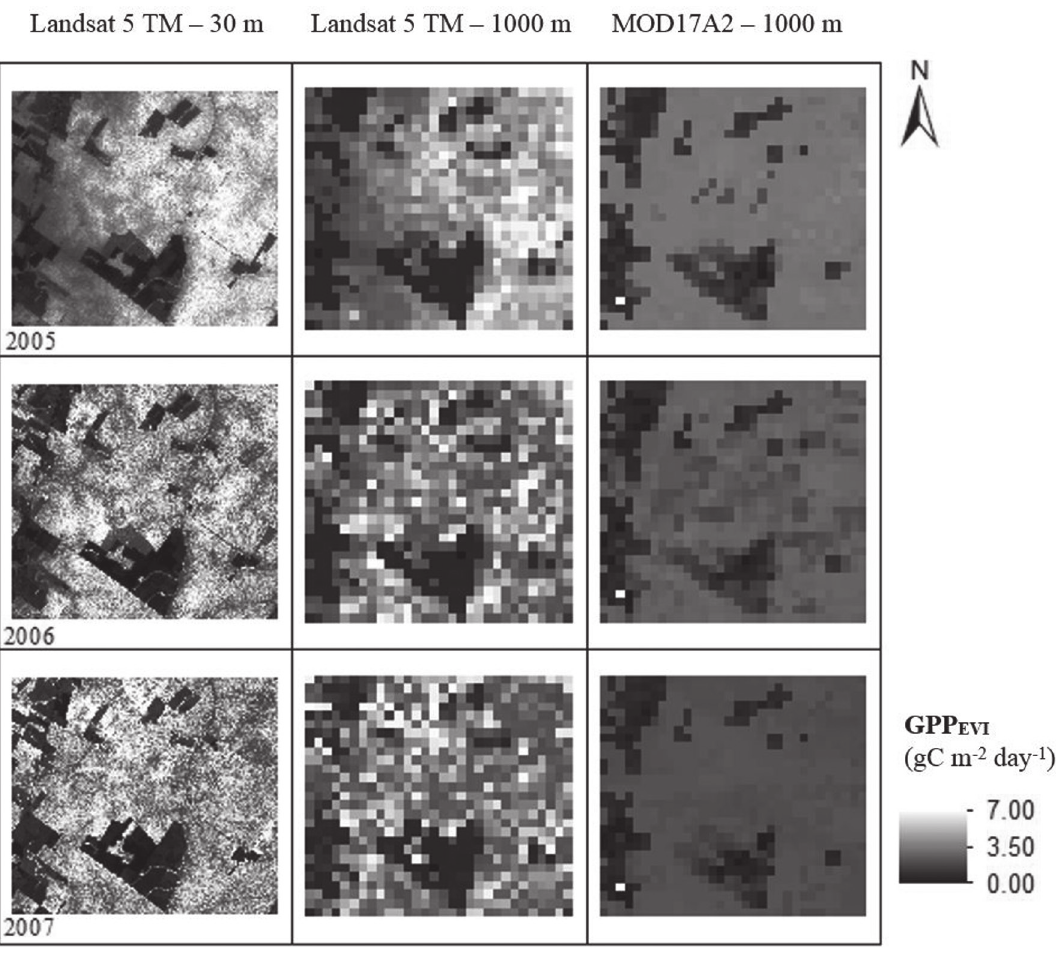
Fig. 7 - Maps of annual average GPP estimated from Vegetation Photosynthesis Model (VPM) using Enhanced Vegetation Index (EVI) from Landsat 5 TM with 30 m and 1000 m of spatial resolution and by MOD17A2 MODIS GPP